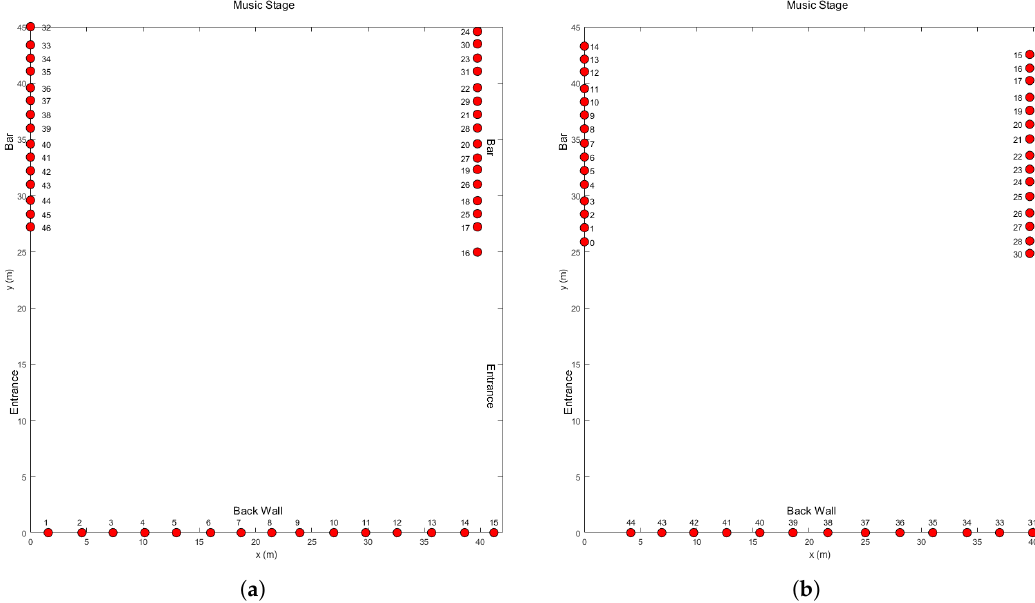
Figure 24. Overviews of the Freedom stage environment for the 2017 and 2018 editions of Tomorrowland, shown respectively in ( a , b